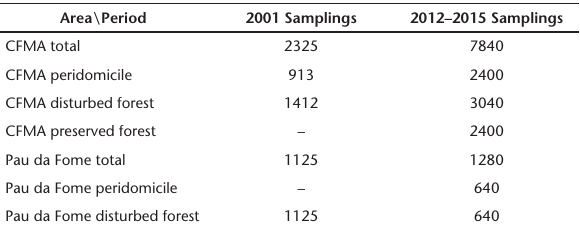
Table 1. Trapping effort for the 2001 and 2012–2015 samplings in CFMA and Pau da Fome for each type of habitat, Rio de Janeiro, Brazil.